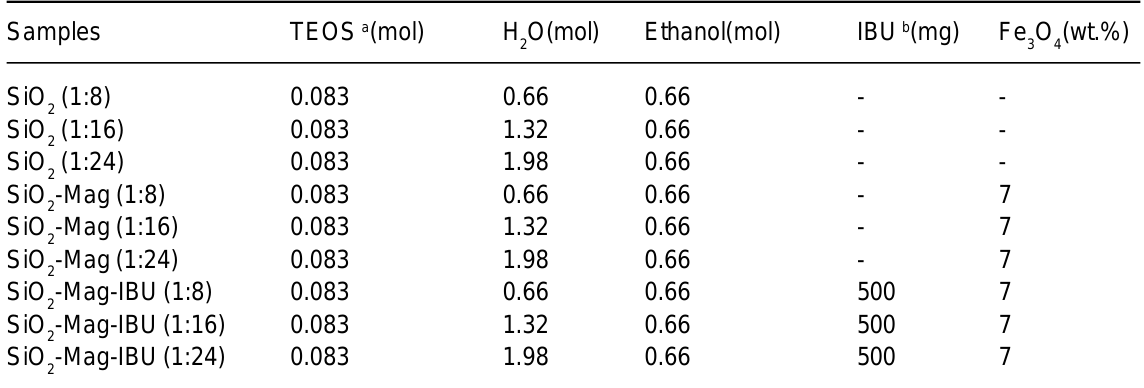
Table 1. Experimental amounts of chemical substances used to prepare different magnetic silica samples. The amounts were adjusted to obtain 5 g of SiO 2